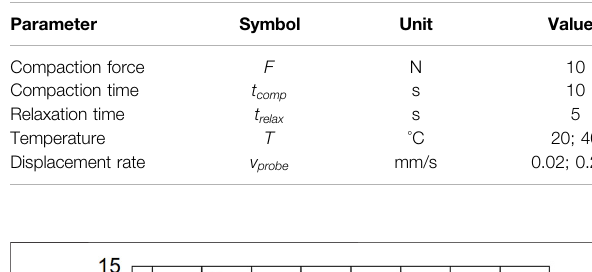
TABLE 1 | Probe tack test — test parameters.